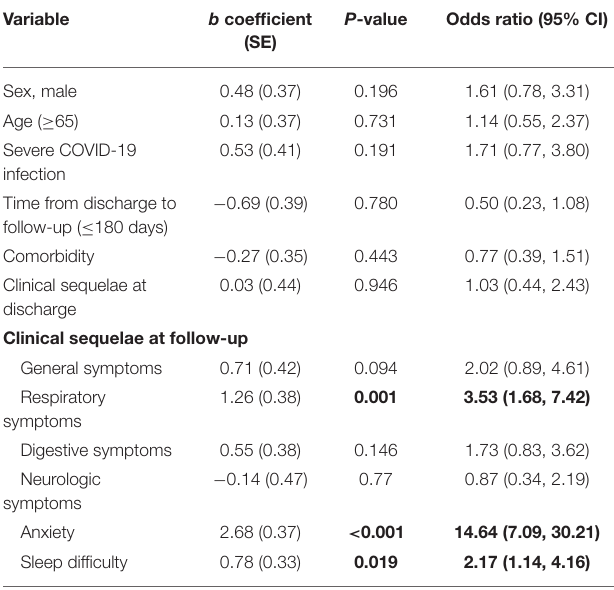
TABLE 4 | Factors associated with PTSD: Binary